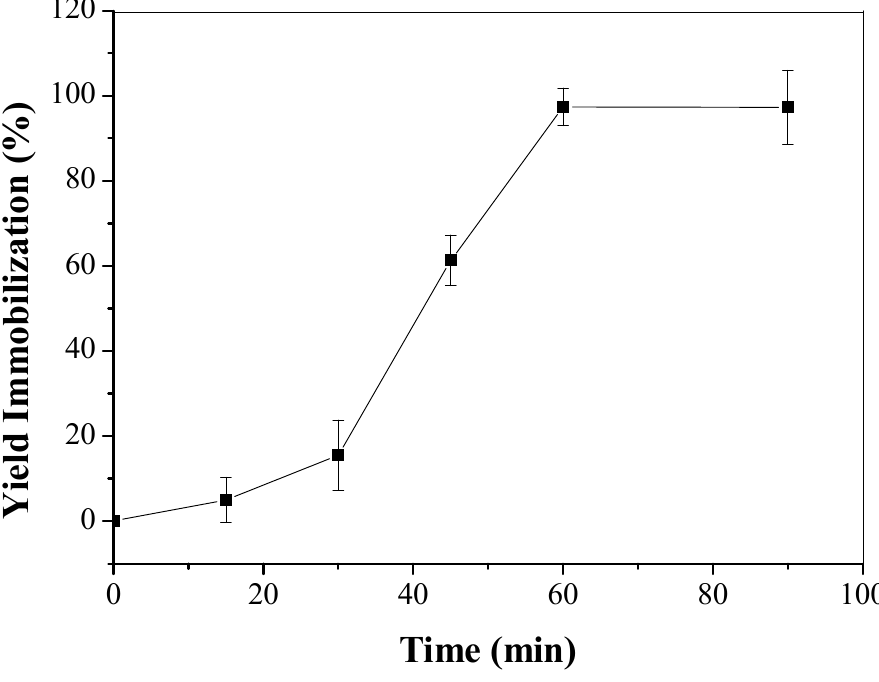
Figure 4. Yield of immobilization versus incubation (immobilization) time for LU in CTA support. The error bars are derived from triplicates.